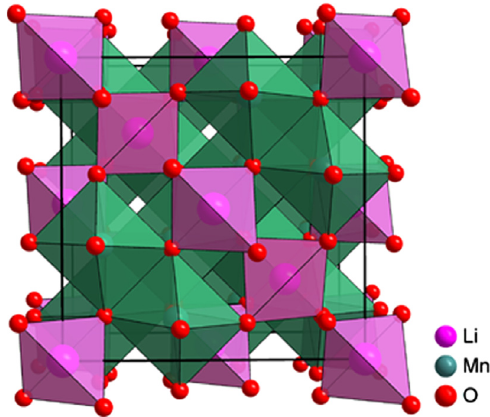
Figure 2. Crystalline structure of spinel LiMn 2 O 4 [13].